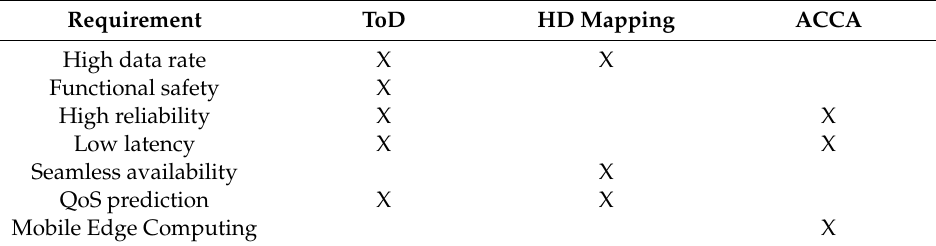
Table 1. Summary of the 5G requirements of 5GCroCo use